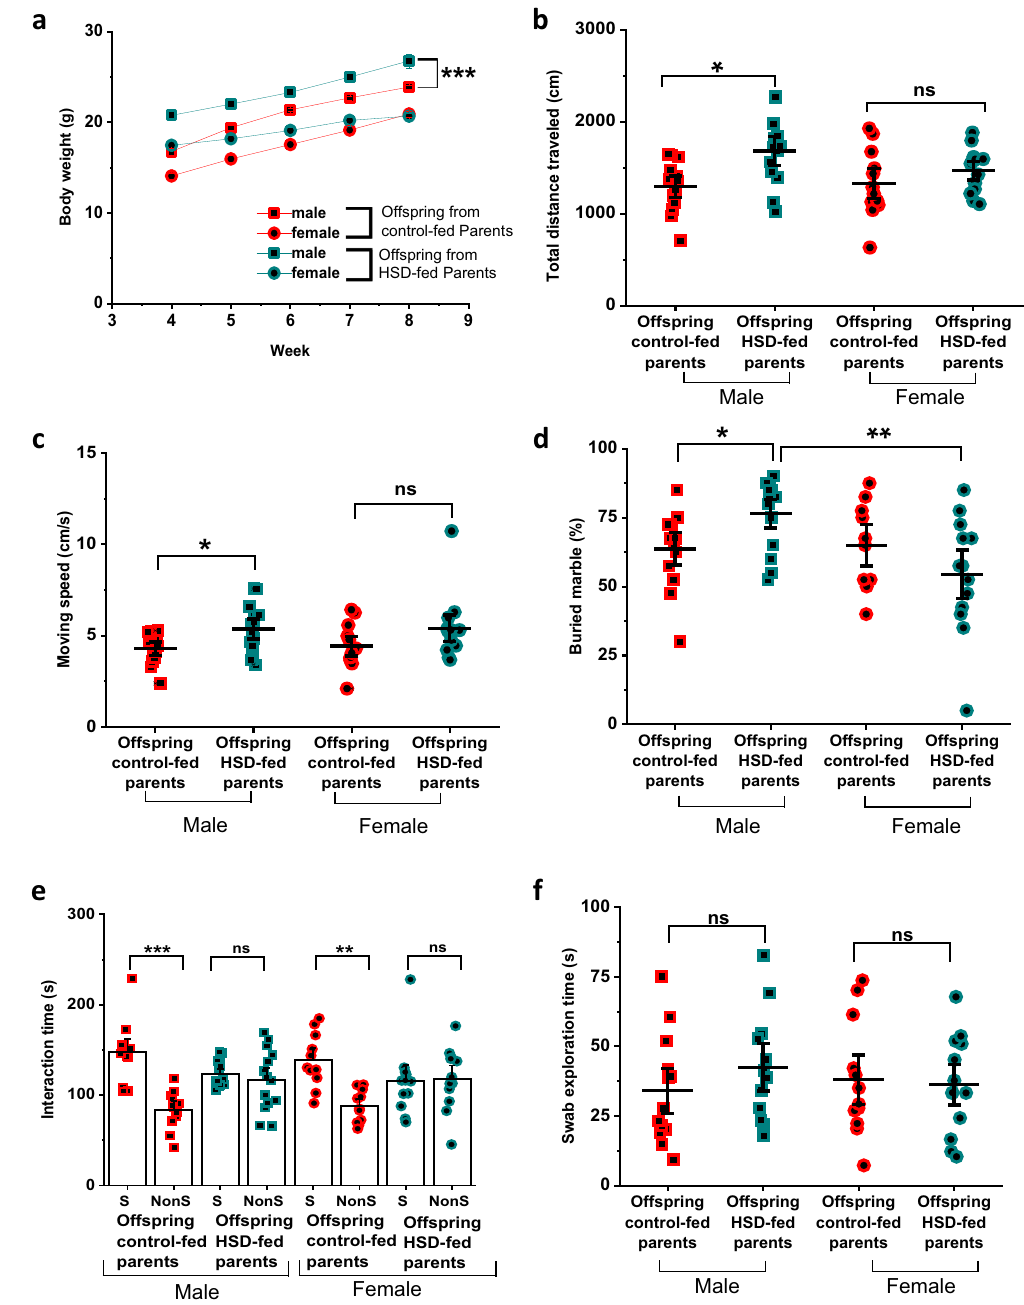
Figure 5. Male offspring from HSD-fed mice are heavier and show ASD-like behavioral phenotype. Body weight of the offspring generation was measured from weaning to adulthood. ( a ) Male and female offspring from HSD-fed parents weigh significantly higher at the age of weaning and only male mice continued to weigh more until their 8th week (n = 30 in all groups). ( b , c ) Male offspring from HSD-fed parents show higher distance traveled and moving speed in the OFT (n = 13 male offspring from control-fed parents, 14 male offspring from HSD-fed parents, 12 female offspring from control-fed parents, 13 female offspring from HSD- fed parents). In the marble burying test, male offspring from HSD-fed parents show higher repetitive behavior ( d ). Offspring from HSD-fed parents show lower preference for the Social (S) chamber in the 3-chamber test compared to offspring from control-fed parents, ( e ) but no difference was observed in the urinary pheromone test ( f ). Data are described as mean ± SEM. * p < 0.05, ** p < 0.01, *** p < 0.001, one-way ANOVA and Tukey’s